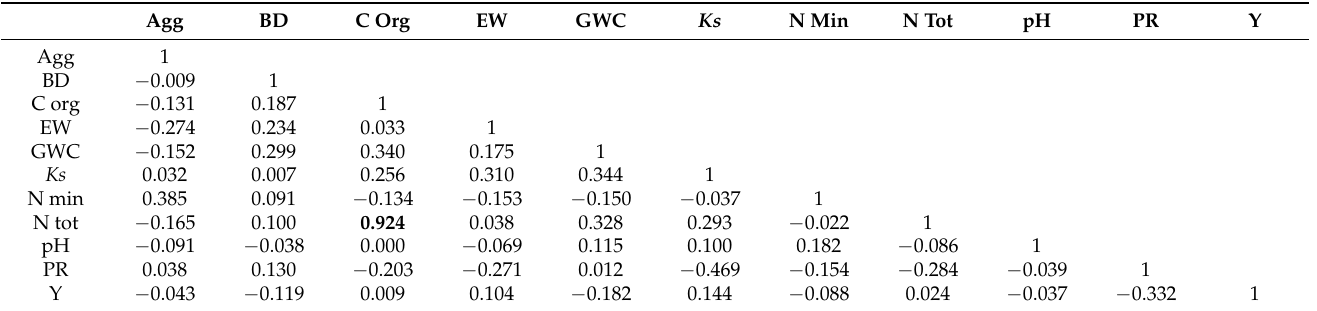
Table 4. Correlation among the parameters. Boldface indicates highly-correlated values (r > 0.8). (Agg—aggregate stability; BD—bulk density; C org—soil organic carbon; N tot—soil total nitrogen; GWC—gravimetric water content; PR—penetration resistance; Ks —saturated hydraulic conductivity; EW—earthworm density; N min—mineral nitrogen).